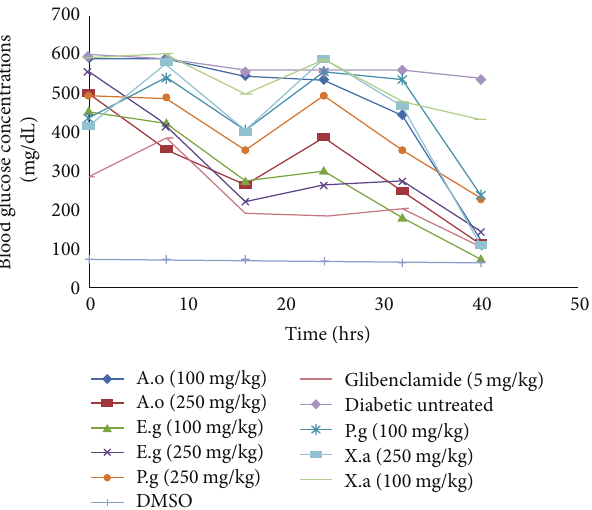
Figure 12: The effect the various plant extracts on blood glucose concentrations at different time intervals. A.o = Anacardium occi- dentale , E.g = Eucalyptus globulus , P.g = Psidium guajava , and X.a = Xylopia aethiopica .